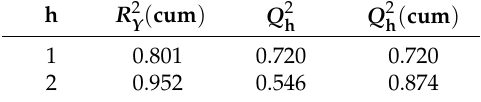
Figure 9. ABB IRB6400 industrial robot. Table 8. Validation results of M 6400 .